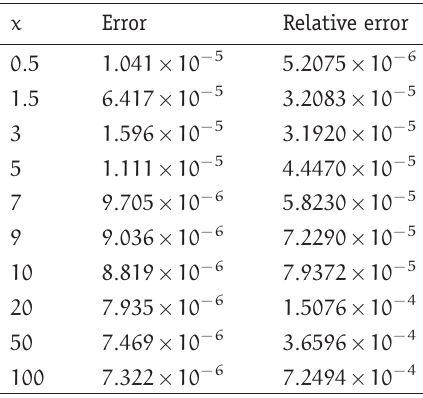
Table 3.2. Error obtained using the [ 5,5 ] Pade´ approximant of the infinite series solution obtained by the Laplace transform numerical algorithm using four